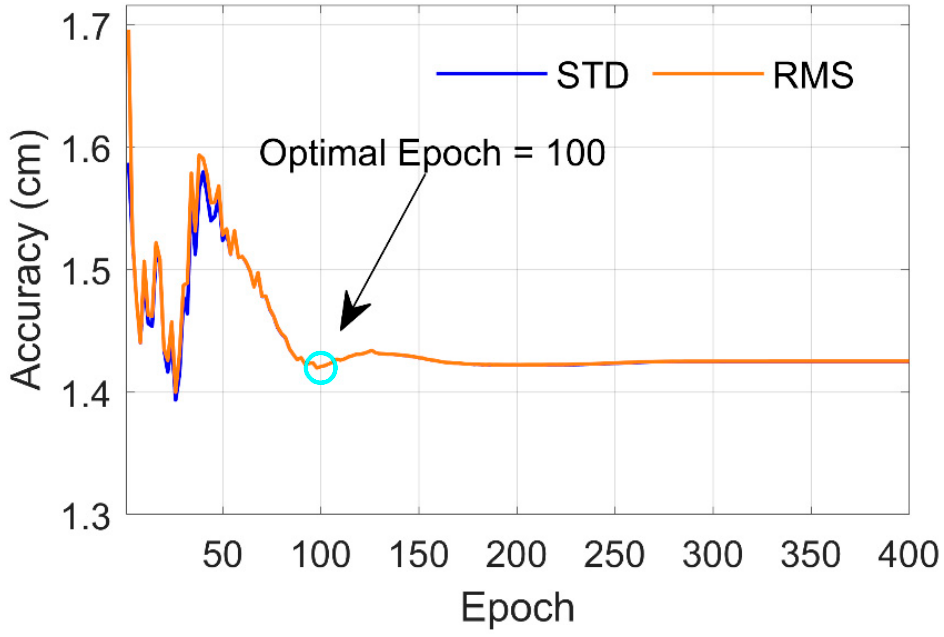
Figure 9. Transformer model accuracy indicators (STD and RMSE) obtained by a cross-validation variation diagram. The cyan circle marks the optimal epoch.